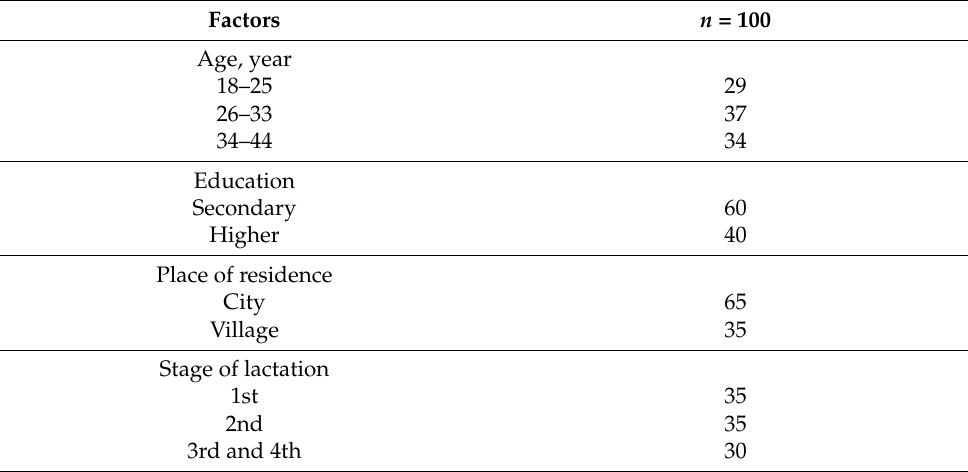
Table 2. Characteristics of the studied breastfeeding